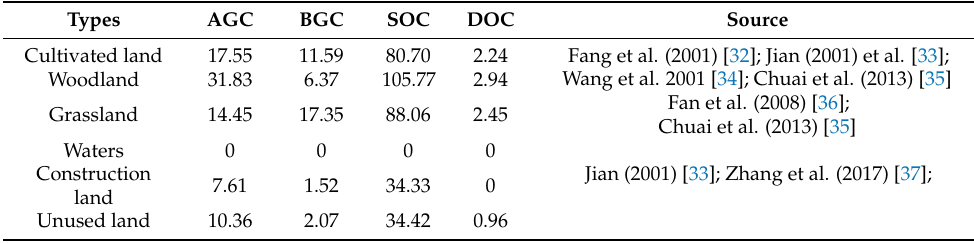
Table 2. Carbon density of each land-use type (unit: Mg/hm 2